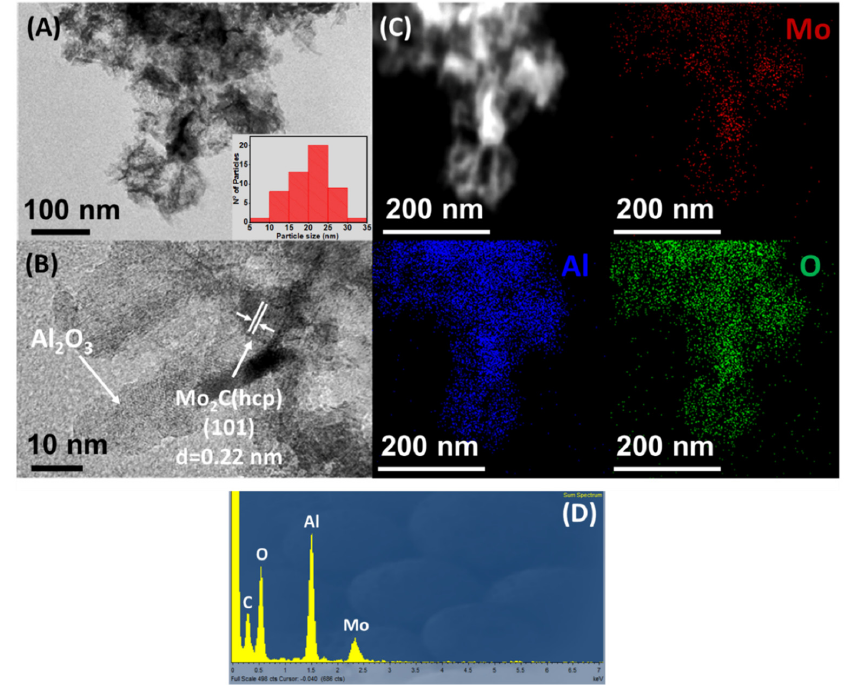
Figure 4. ( A , B ) TEM − HRTEM micrographs of Mo x C/Al 2 O 3 catalyst; ( C ) STEM − EDX mapping; ( D ) EDX spectrum.